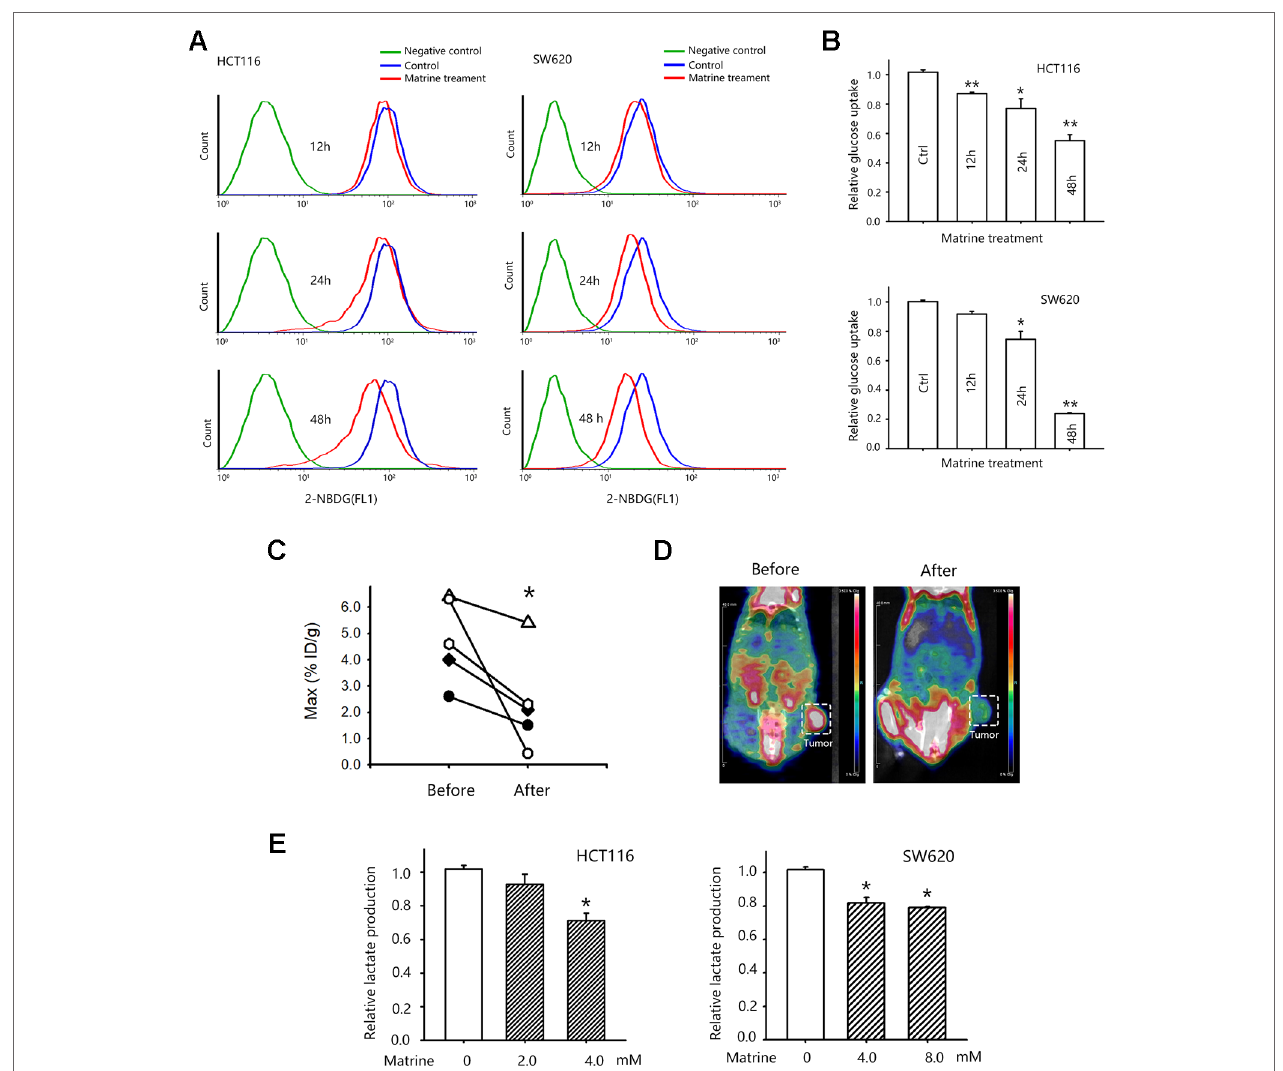
FIGURE 2 | Matrine inhibited glucose uptake of colon cancer cells in vitro and in vivo. (a) Representative pictures of flow cytometry for accessing glucose uptake in HCT116 and SW620 cells. (B) Quantified data of glucose uptake determined by flow cytometry in HCT116 and SW620 cells after matrine treatment. Data were expressed as mean ± SEM, n = 3. *, P < 0.05, **, P < 0.01. (C) Quantified data of glucose uptake determined by microPET/CT. *, P < 0.05, paired Wilcoxon test. (D) Representative microPET/CT images of nude mice bearing subcutaneous SW620 tumor, which were acquired at 40 min after i.v. injection of [18F]-FDG. (E) Lactate production of HCT116 and SW620 cells with the treatment of matrine. Data were expressed as mean ± SEM, n = 4~6. *, P <